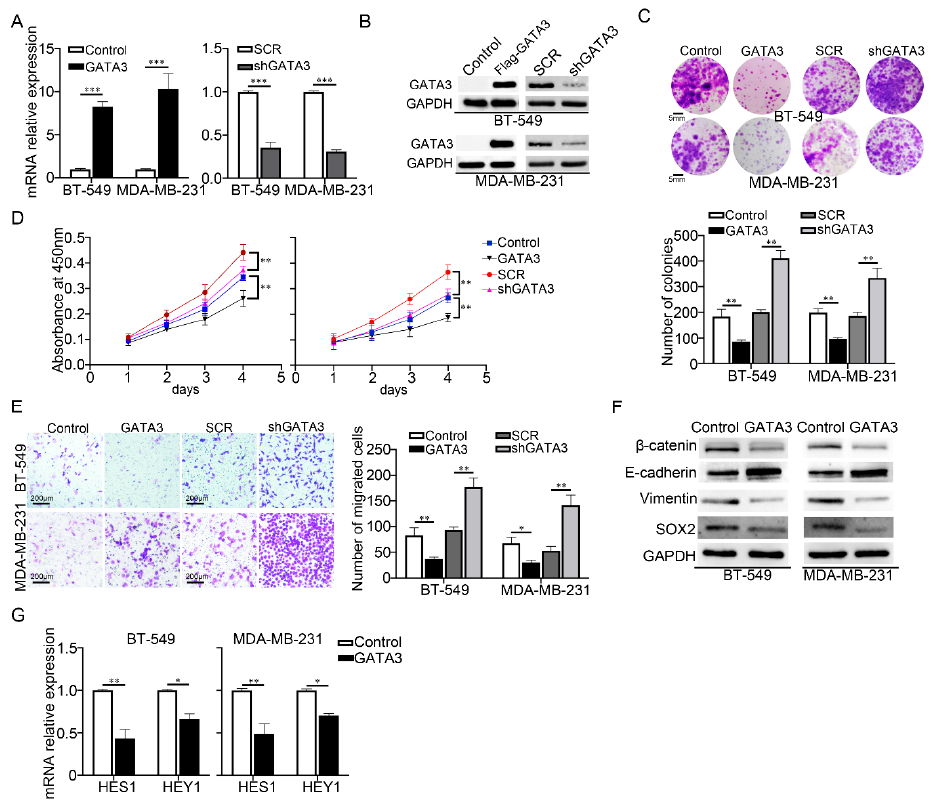
Figure 3. Decreased GATA3 elevated the malignancy of TNBC cells and promoted the activity of Notch signaling. The mRNA ( A ) and protein ( B ) expression levels of GATA3 were investigated in TNBC cells stably overexpressing or knockdown GATA3, SCR was short for Scramble and GAPDH served as an internal control. ( C ) Colony formation assay showing the number of colonies formed after transfecting indicated TNBC cells overexpressing or knockdown GATA3. ( D ) CCK-8 assay was conducted to evaluate the effect of GATA3 on cell growth in TNBC cells. ( E ) The role of GATA3 in TNBC cell migration was assessed by transwell migration assay in TNBC cells overexpressing or knockdown GATA3. ( F ) Western blot analysis of EMT and growth-related markers protein levels in the indicated TNBC cells, GAPDH was loaded as an internal control. ( G ) RT-qPCR analysis of the mRNA expression level of Notch target genes HES1 and HEY1 in GATA3-transfected TNBC cells, GAPDH served as an internal control. Data were analyzed using a Student’s t -test. All * p < 0.05, ** p < 0.01, *** p <